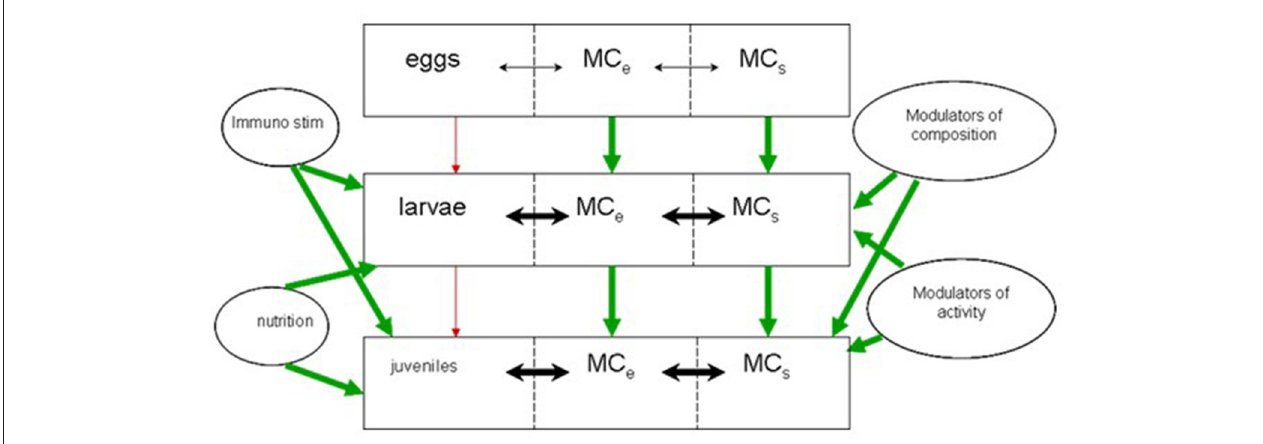
FIGURE 2 | Conceptual framework for the microbial interaction between system and host MC e : Microbial community of biological components, MC s : Microbial community of the system, water and non-living components.